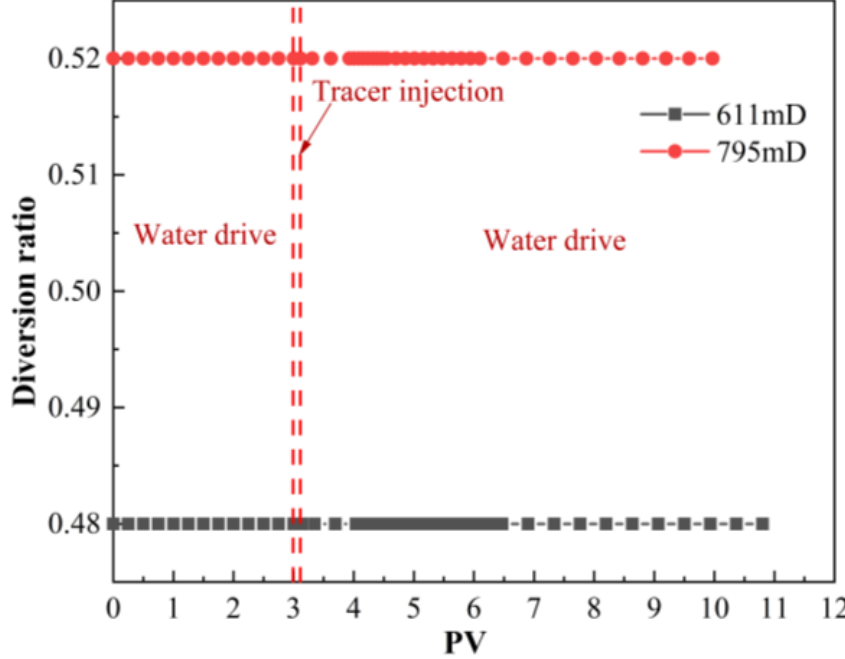
Figure 15. The cumulative volume of CQD-W versus injection volume.